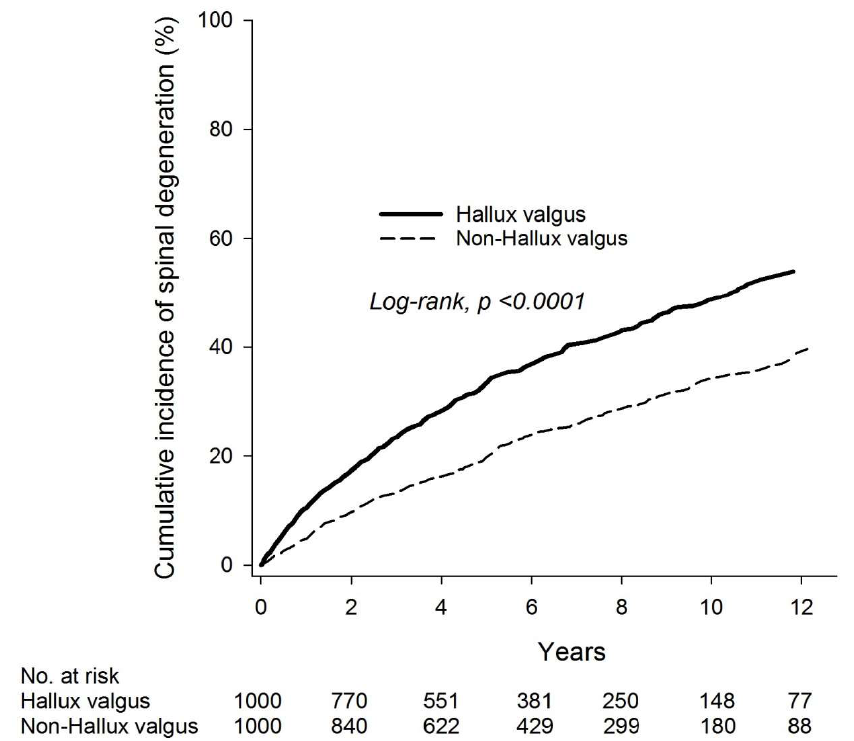
Figure 1. Kaplan–Meier analysis for incidence of spinal degeneration.